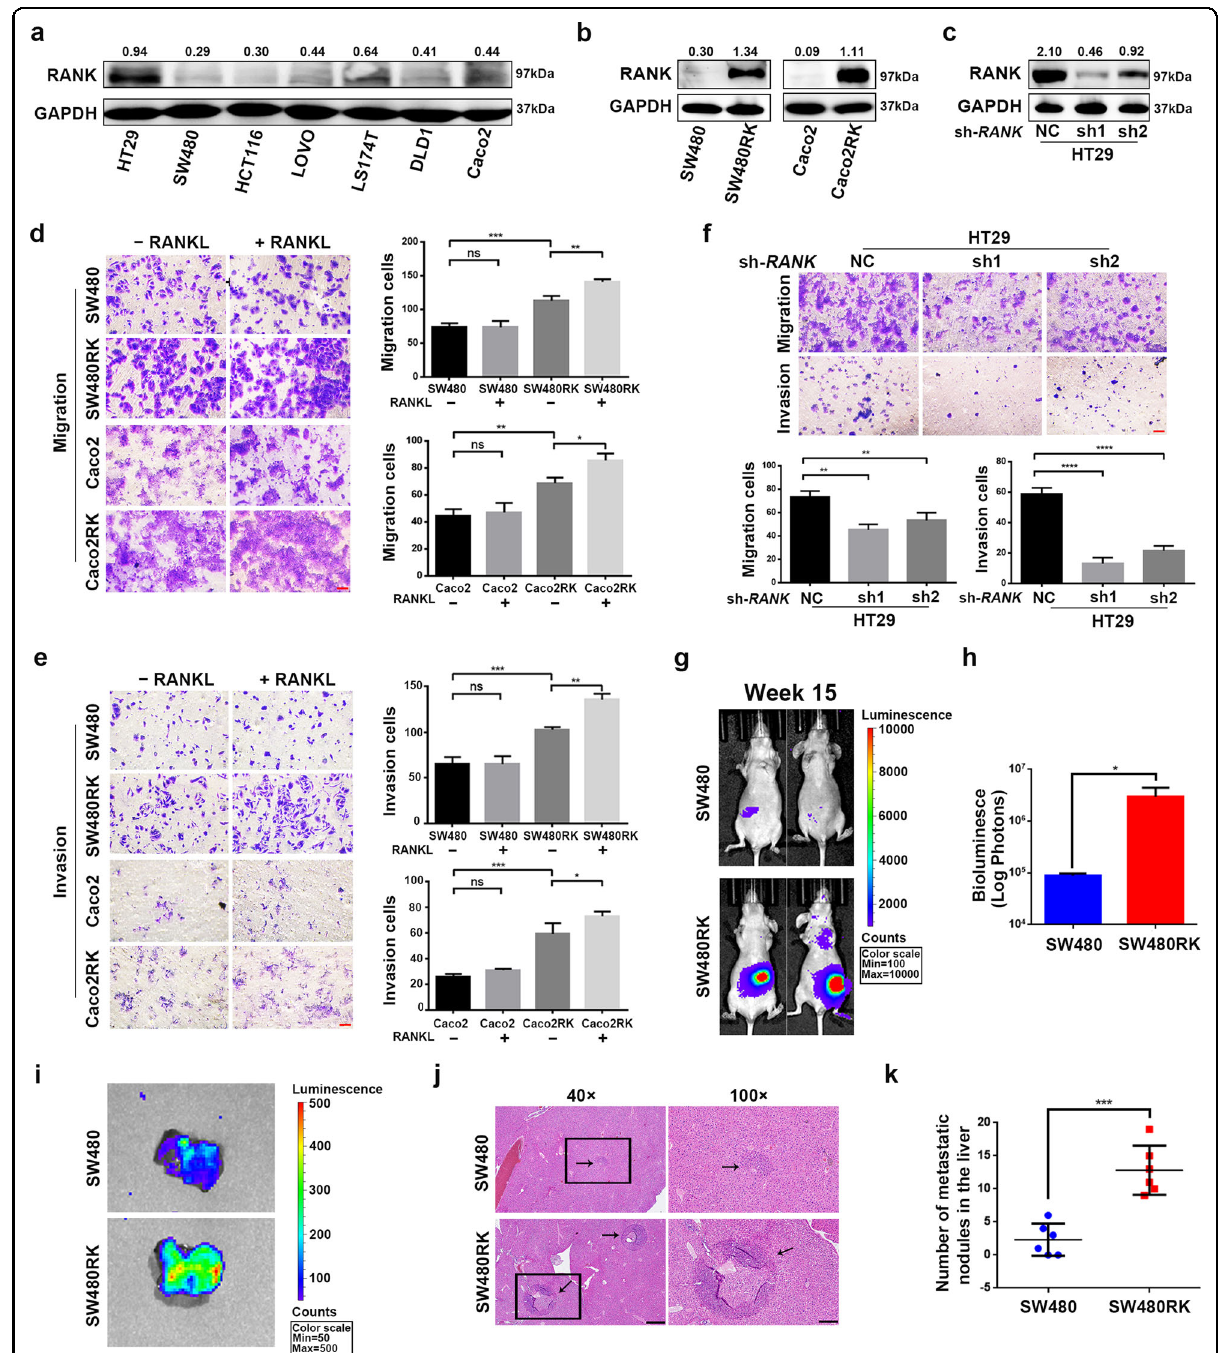
Fig. 2 RANK promoted the metastasis of CRC cells in vitro and in vivo. a Protein expressions of RANK were detected by western blot analysis in seven CRC cell lines. b , c RANK stable overexpression or knockdown ef fi ciency was con fi rmed by western blotting in CRC cells. d , e RANK overexpression promoted the migration and invasion of SW480 and Caco2 cells. And the addition of 100ng/ml RANKL moderately increased the migration and invasion of RANK -overexpressing SW480 and Caco2 cells. Scales bars = 100 μ m. f Knockdown of RANK inhibited the migration and invasion of HT29 cells. Scales bars = 100 μ m. g Bioluminescent images of representative mice at week 15 after implantation. h The total tumor burden is quanti fi ed as total photons measured by bioluminescent technology. i Livers were excised for ex vivo bioluminescent imaging. j Representative results for staining of metastatic nodules (black arrows) in the livers. Scales bars = 500 μ m (40×), 200 μ m (100×). k The statistical analyses of metastatic nodules. Data are mean ± SD ( n = 3; n = 6 mice/group for in vivo experiments). * P < 0.05, ** P < 0.01, *** P < 0.001, **** P <